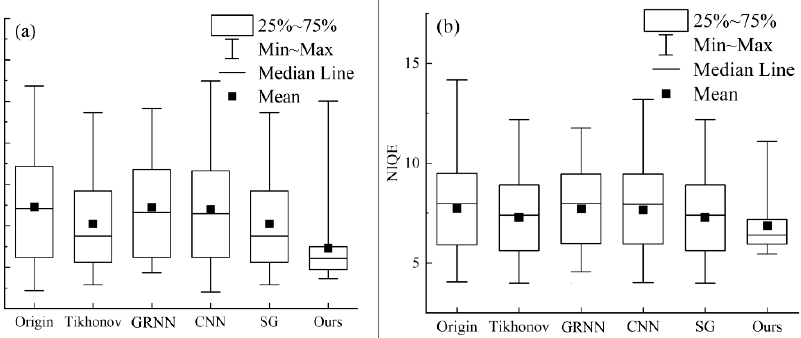
Figure 14. The no reference image quality evaluation score. ( a ) The BRISQUE score. ( b ) The NIQE score.